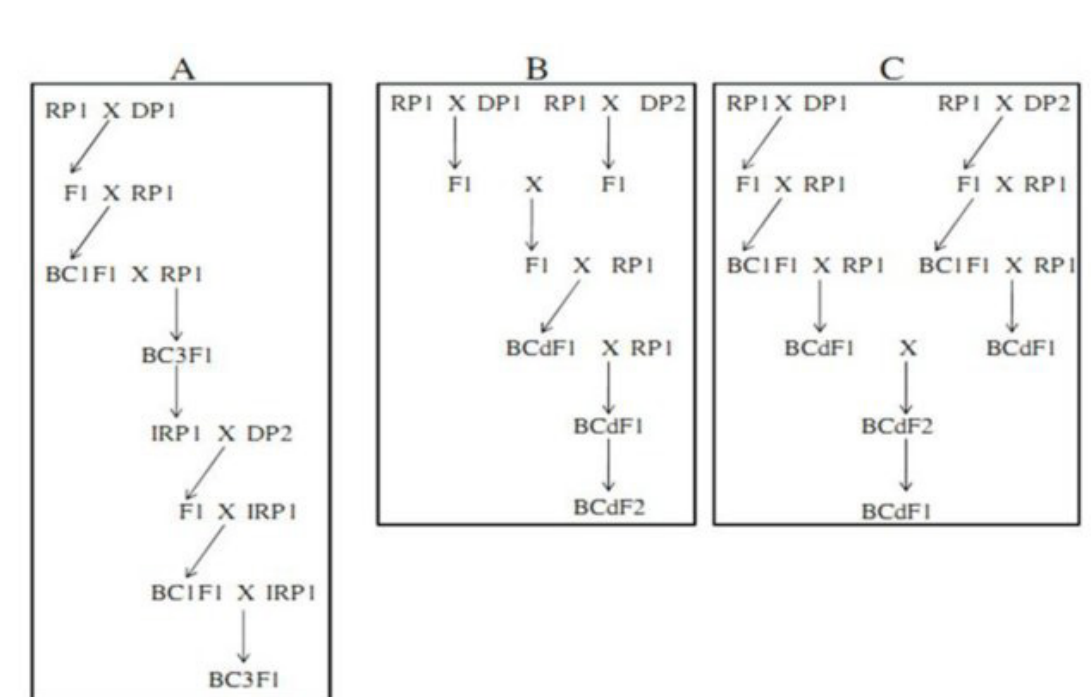
Figure 2: Different Schemes of gene pyramiding. RP= Recurrent parent; DP= Donor parent; BC= Backcross; IRP= Improved recurrent parent. A. Stepwise transfer; B. Simultaneous transfer; C. Simultaneous and stepwise transfer. (Adopted from Malav & Chandrawat,